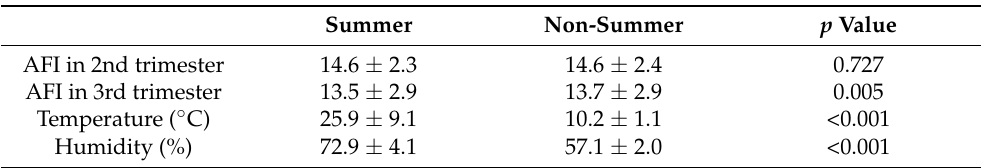
Table 2. Amniotic fluid index (AFI), temperature, and humidity in the summer versus non-summer seasons for a period of 15 years.